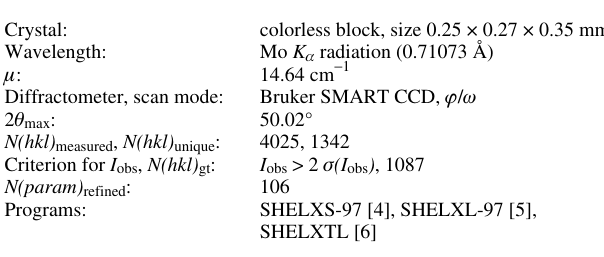
Table 1. Data collection and handling.